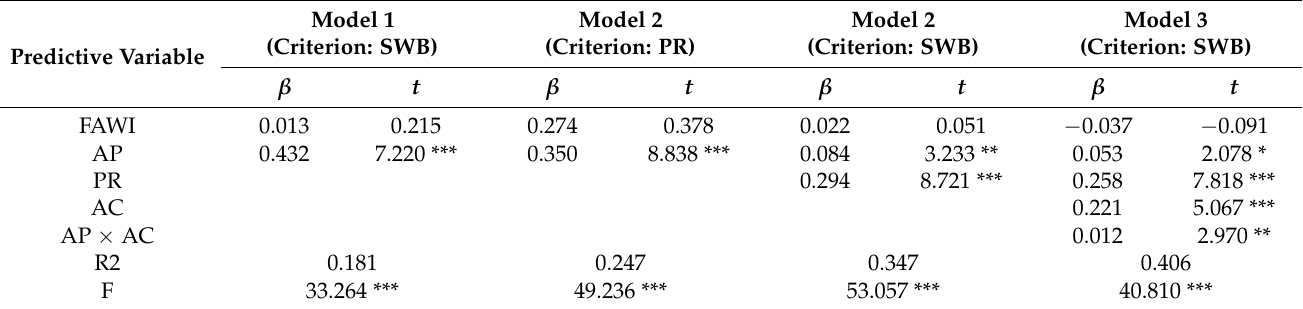
Table 4. The moderating role of the academic climate in the relationship between AP and SWB.